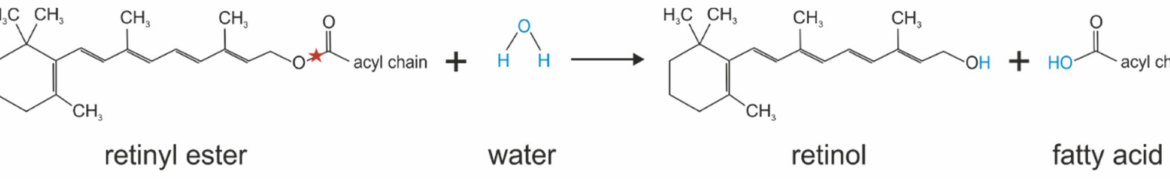
Figure 7. Retinyl ester hydrolysis catalyzed by KIAA1363. Red stars indicate the bond that is